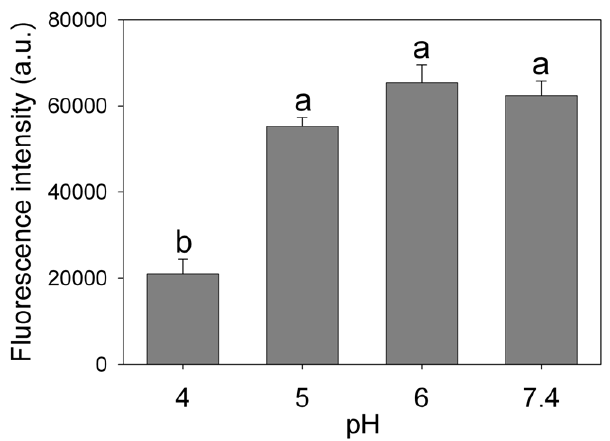
Figure 2. pH dependence on bis-ANS binding to apoA-I. ApoA-I was incubated in optically dark, 96 well microplates, at pH 4.0, 5.0, 6.0 or 7.4 at 37 u C for 24 h. Final concentration of apoA-I was 0.1 mg/mL. Bis-ANS was added at a 2:1 molar ratio to protein, and fluorescence was measured in a Multiplate Reader (excitation at 395 nm, emission at 490 nm). Bars correspond to means 6 SE. Bars denoted by different letters differ significantly at p , 0.05.